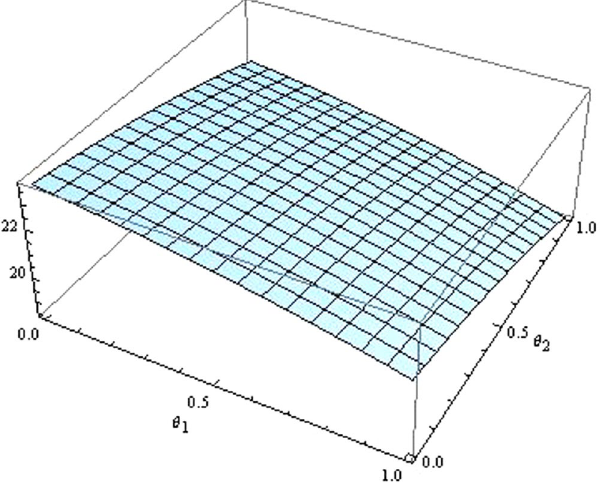
Figure 7. The impact of technological spillovers on the product price in the centralized scenario.